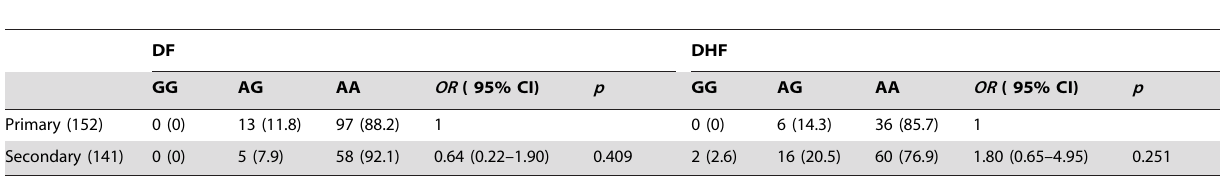
Table 4. Distribution of CD209 2 336 A/G genotype in patients with primary and secondary dengue